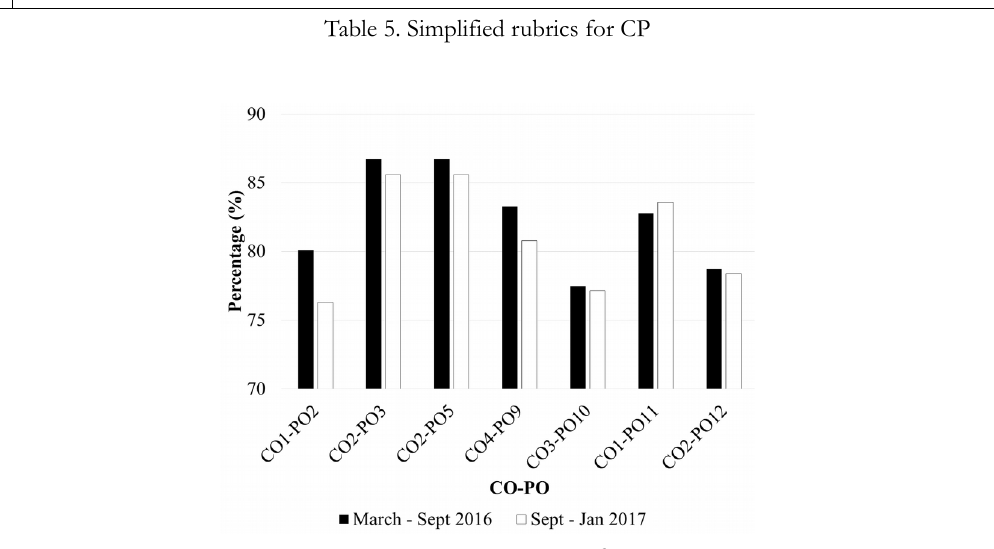
Figure 2. CO-PO attainment for